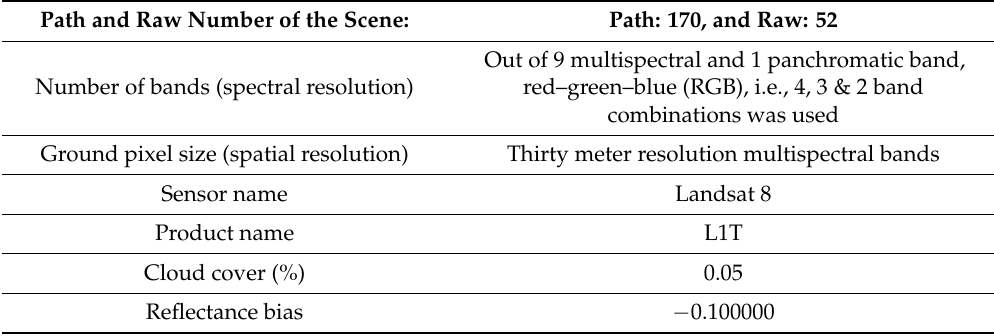
Table 2. Characteristics of the satellite imagery used for analyzing land-use land cover classes. Path and Raw Number of the Scene: Path: 170, and Raw: 52 Out of 9 multispectral and 1 panchromatic Number of bands (spectral resolution)